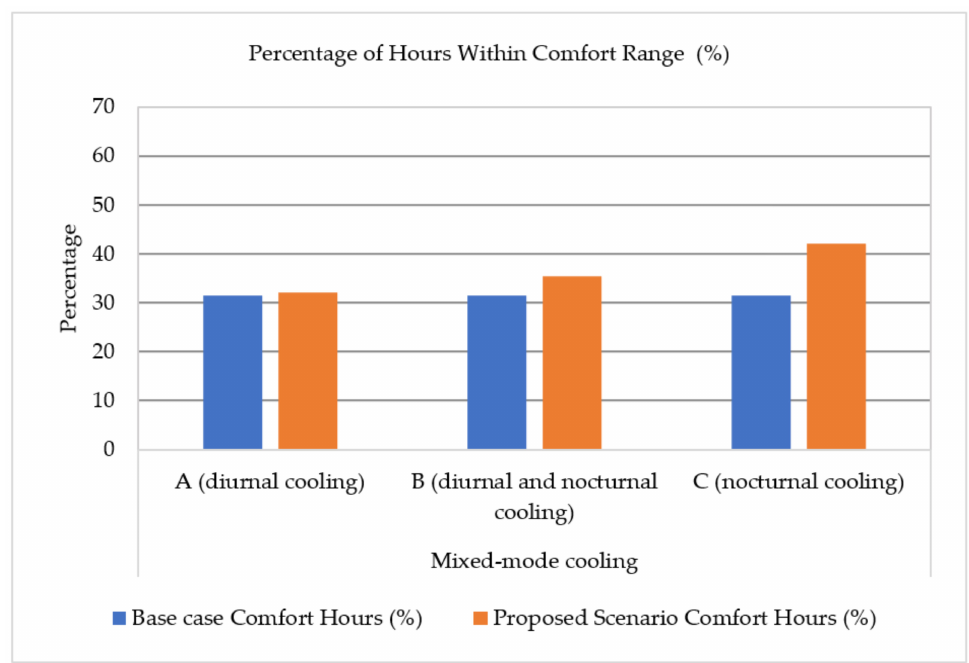
Figure 5. A comparison between the comfort hours in the base case and the proposed cooling scenarios.